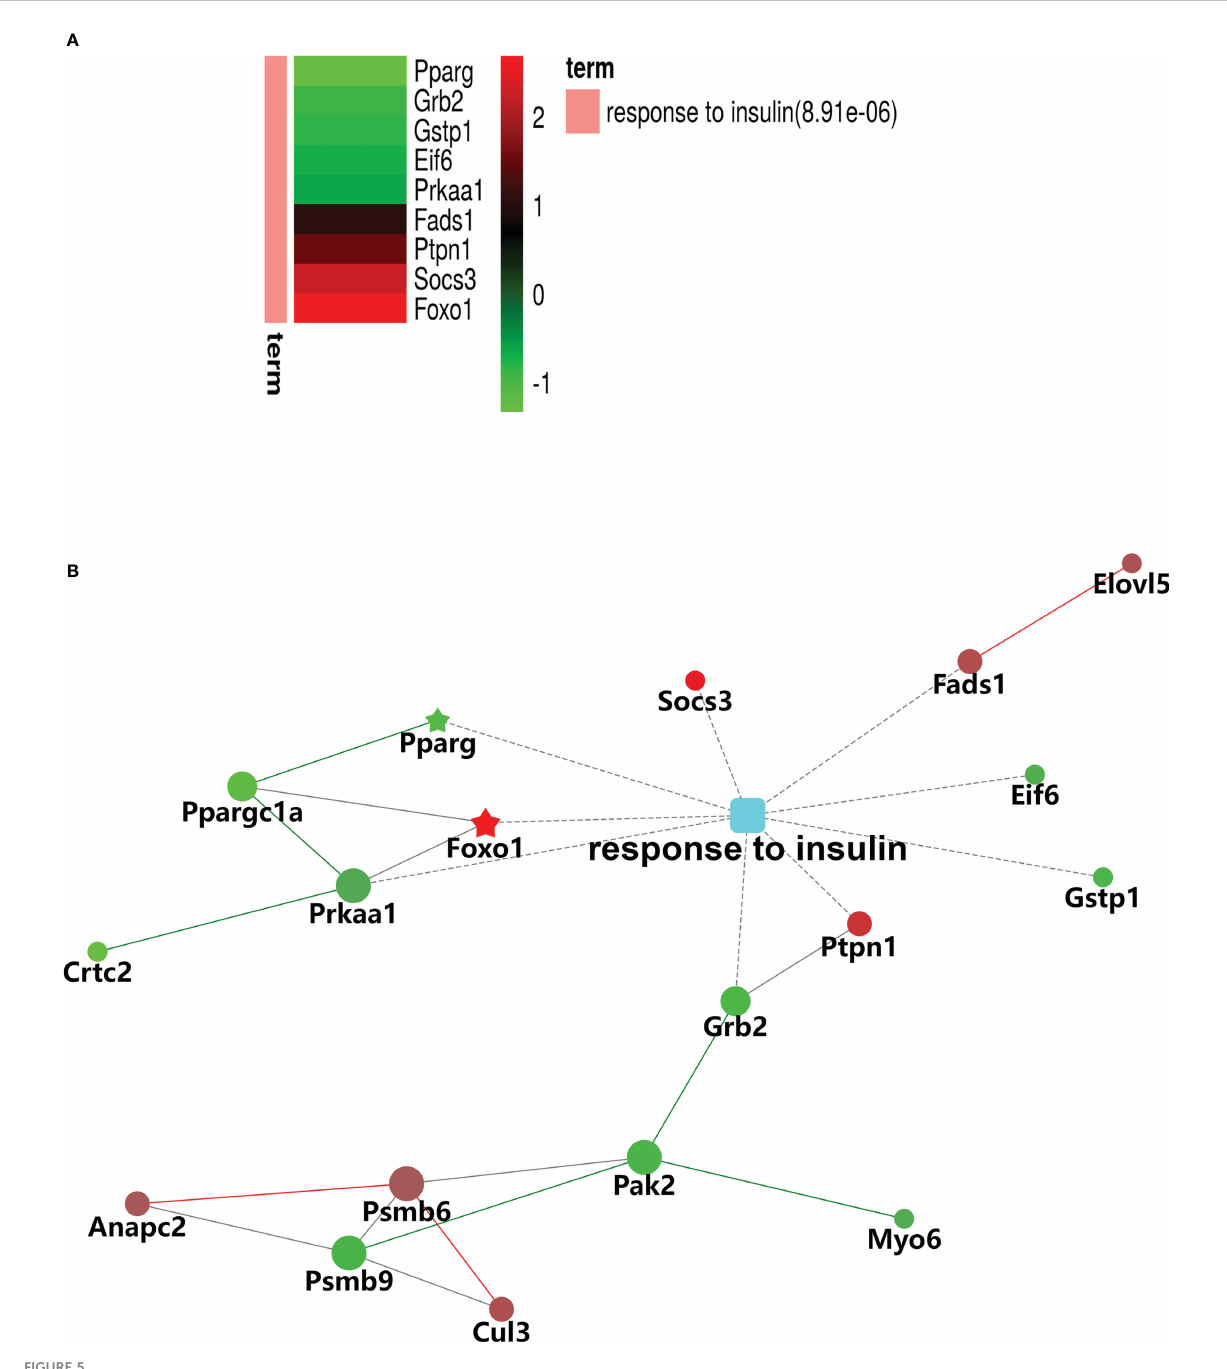
FIGURE 5 Gene Ontology (GO) enrichment analysis of biological processes for DEPs involved in insulin signaling pathways. (A) Heatmap of nine DEPs in response to insulin. (B) Protein – protein interaction (PPI) network of DEPs associated with the response to insulin. The red signal represents upregulation and green signal represents downregulation. The red pentagram represents the most pronounced upregulation and green pentagram represents the most pronounced